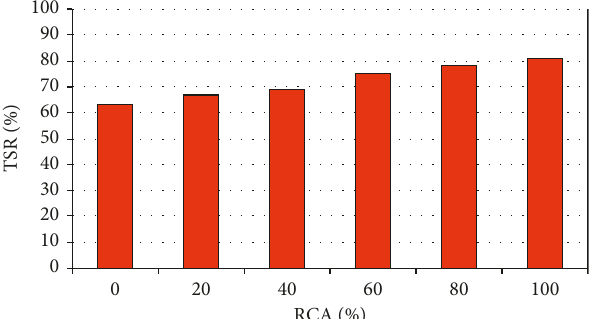
Figure 11: WRU unconditioned specimens after the indirect tension test. (a) WRU 0%; (b) WRU 100%.